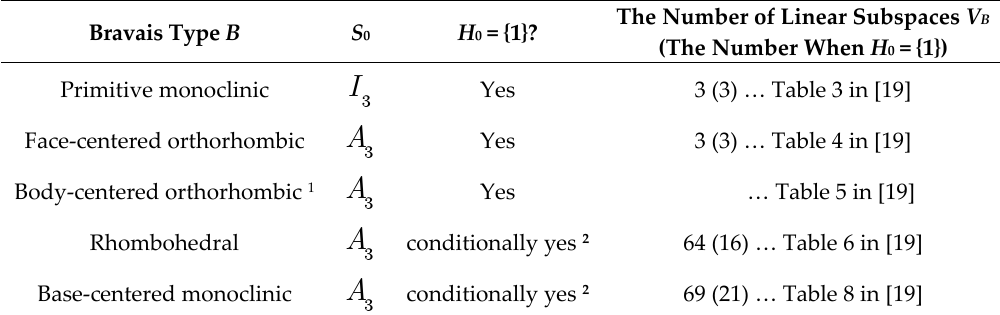
Table 2. B , S 0 , V B in Theorem